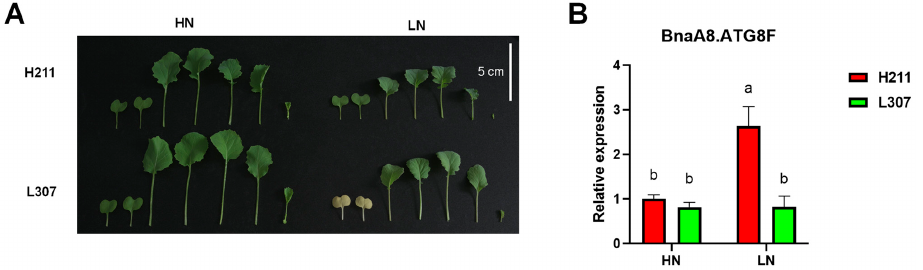
Figure 7. Natural variation in rapeseed resistance to low nitrate of resistant and sensitive genotypes. ( A ) Representative images of leaves of the low nitrogen tolerance genotype H211 and the low- nitrogen sensitive genotype L307 after 10 d treatment with HN, 6 mM NO 3 − and LN, 0.3 mM NO 3 − . ( B ) Relative expression of BnaA8ATG8F between H211 and L307. Significant differences were determined using a one-way ANOVA followed by Tukey’s HSD test ( p < 0.05).